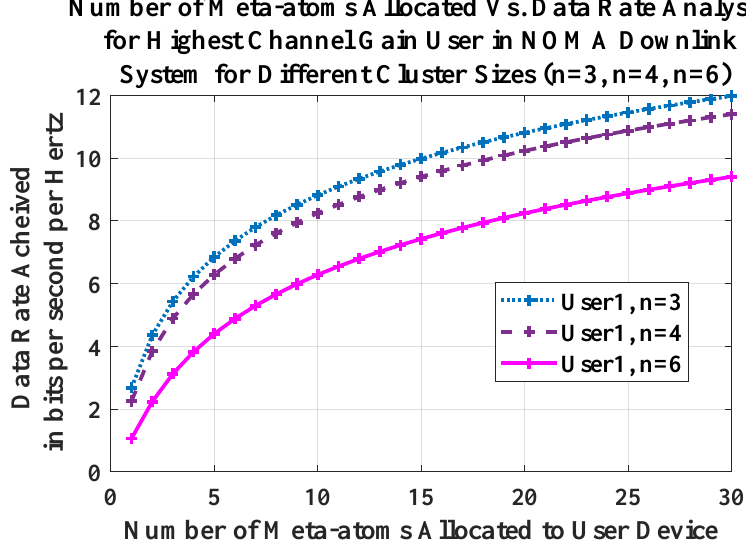
Figure 6. Data-rate comparison for different cluster size highest channel gain user